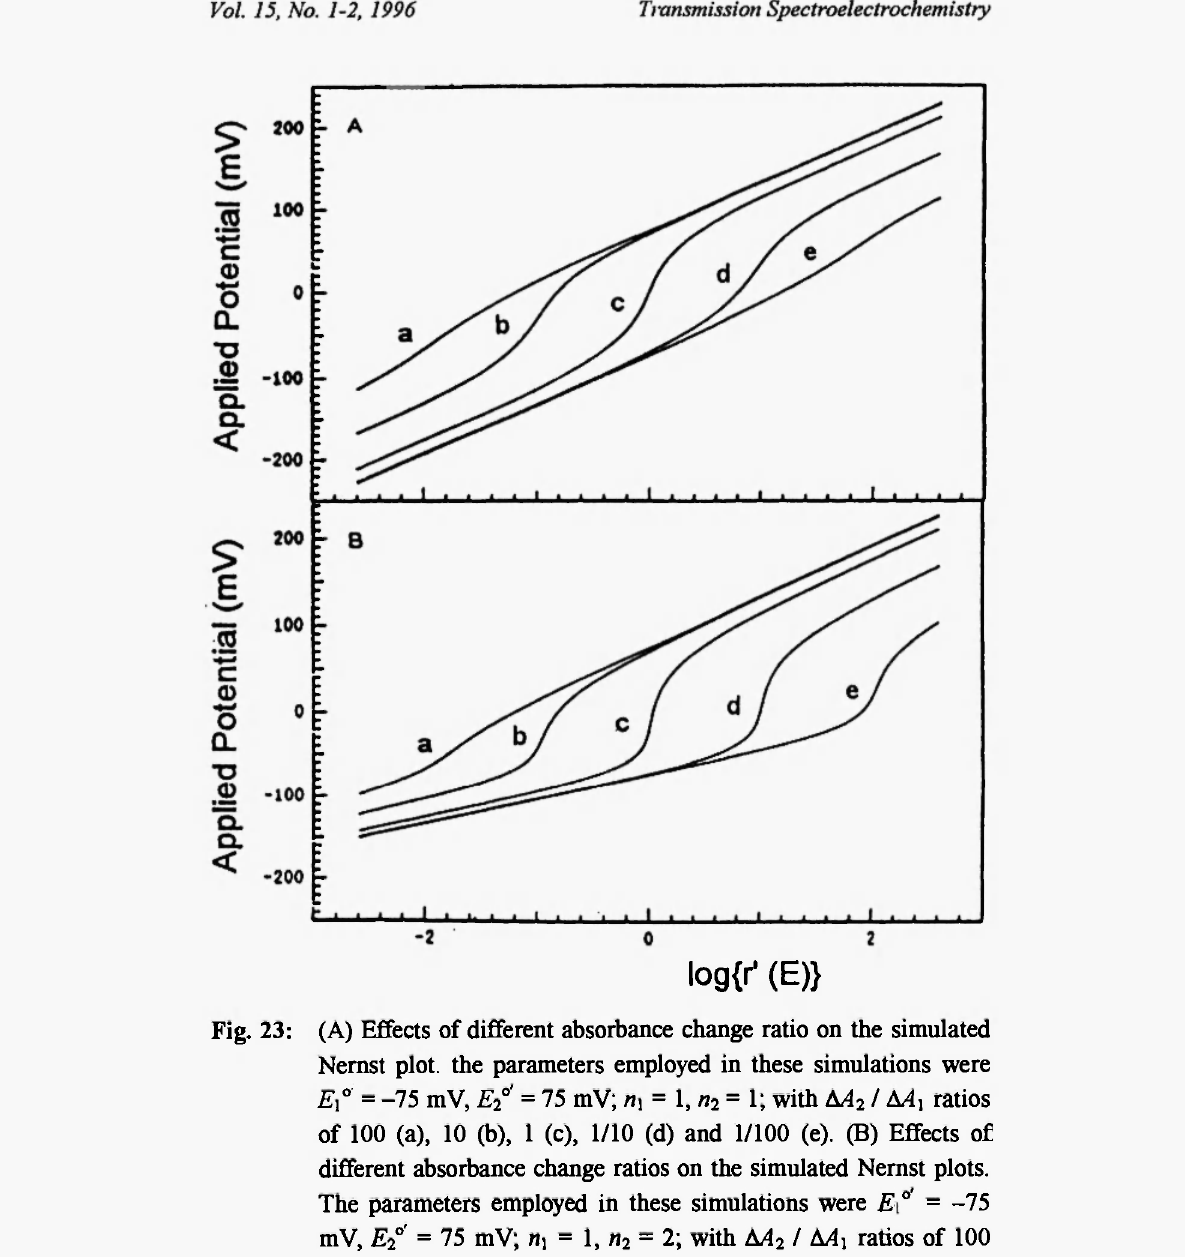
Fig. 23: (A) Effects of different absorbance change ratio on the simulated Nernst plot, the parameters employed in these simulations were E\° = -75 mV, E 2 °' = 75 mV; = 1, n 2 = 1; with AA 2 / Δ/l, ratios of 100 (a), 10 (b), 1 (c), 1/10 (d) and 1/100 (e). (B) Effects of different absorbance change ratios on the simulated Nernst plots. The parameters employed in these simulations were E°' = -75 mV, E 2 °' = 75 mV; n, = 1, n 2 = 2; with AA 2 / M, ratios of 100 (a), 10 (b), 1 (c), 1/10 (d) and 1/100 (e) (From Ref.